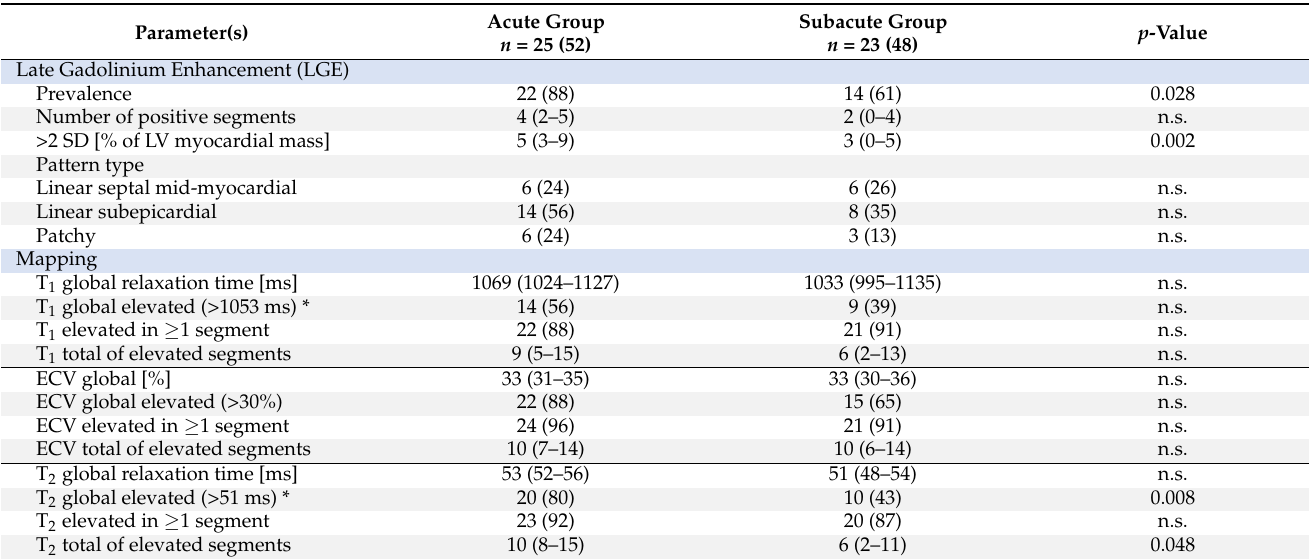
Table 4. CMR Tissue Characterization of Acute and Subacute